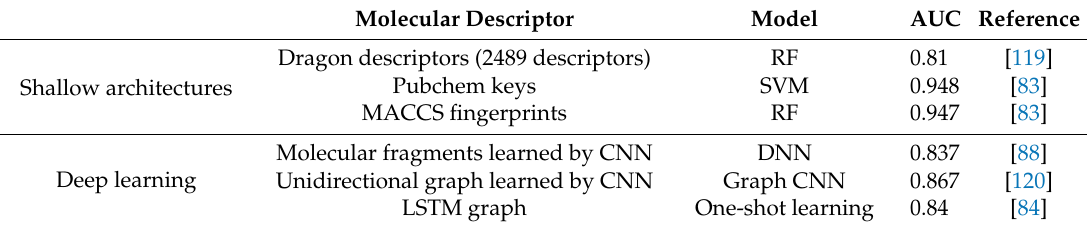
Table 3. Comparison of area under the curve (AUC) scores among different combinations of molecular descriptors and machine learning